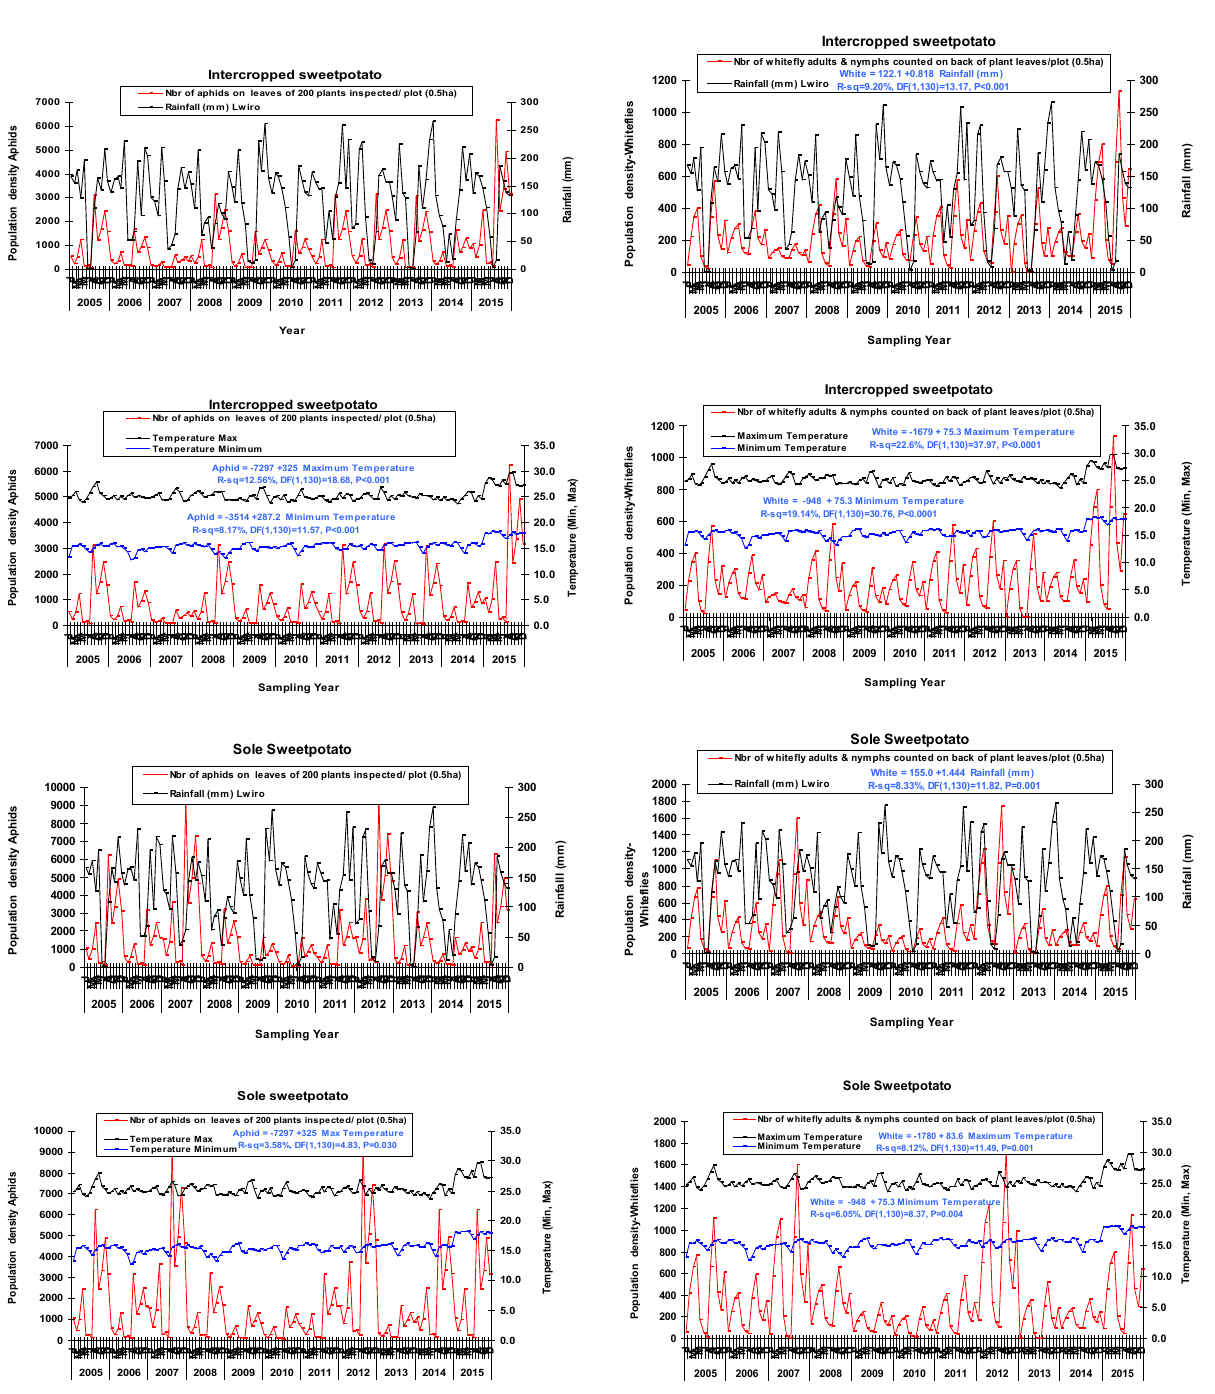
Figure 6: Fluctuation of the population density of the aphid pest in relationship with variability in climatic factors (rainfall, temperature) under intercropping and mono-cropping systems in Kivu Province, eastern DRCongo